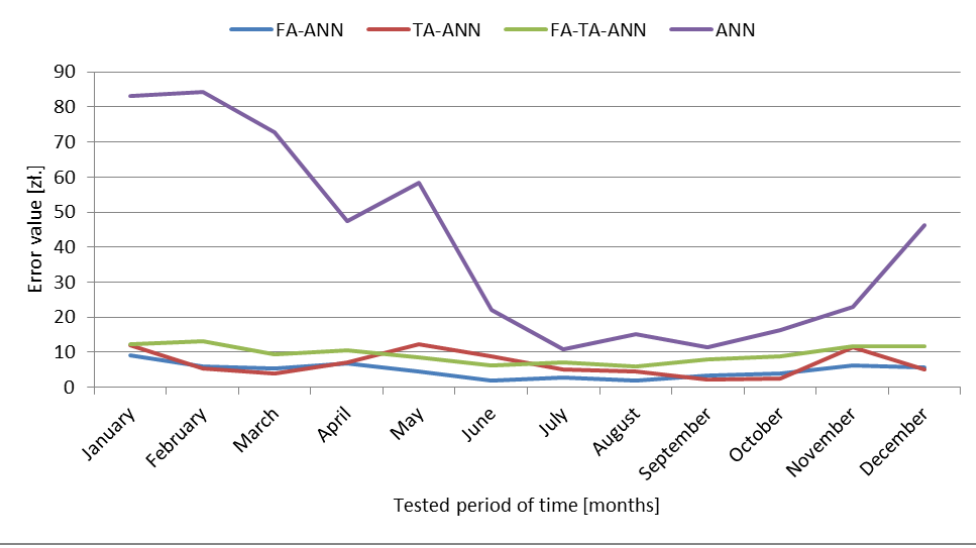
Figure 7. Comparison of E max values per month using ANN-based models over one year (2010) for BPH Bank SA.